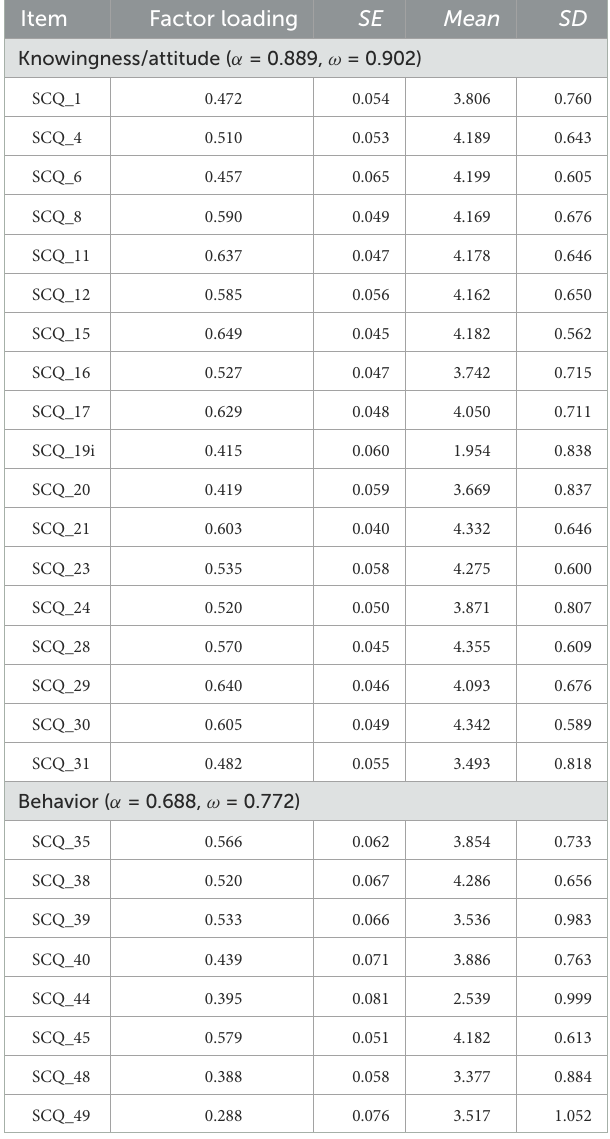
TABLE 4 Factor loading of each item for the two-factor